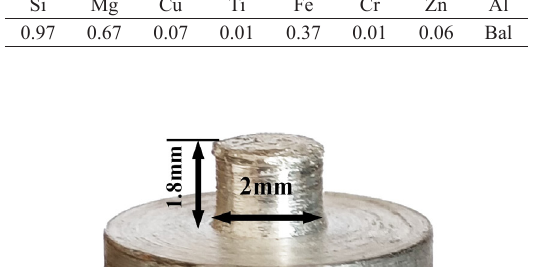
Table 1. Nominal compositions of the 6082 aluminium alloy employed in this work (wt%). Si